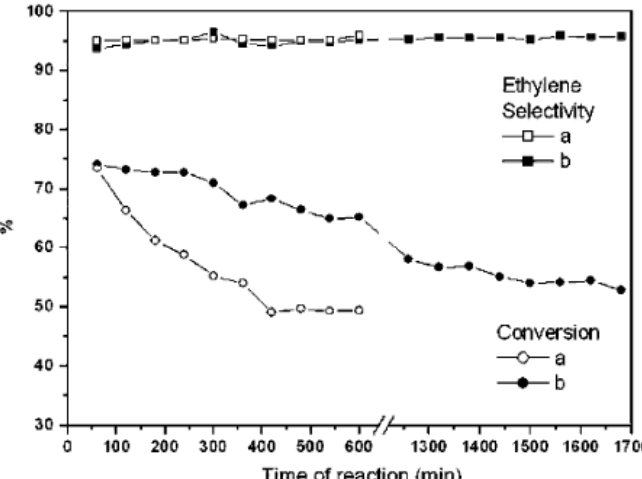
Figure 9. Conversion and selectivity for the hydrodechlorination of 1,1,2-trichloroethane over ( a ) Pd/SBA-15 and ( b ) Pd/plugged SBA-15 [18].